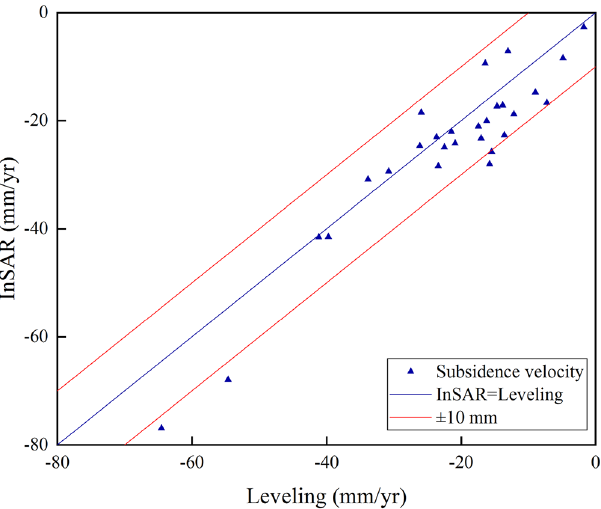
Figure 4. Validation of IPTA